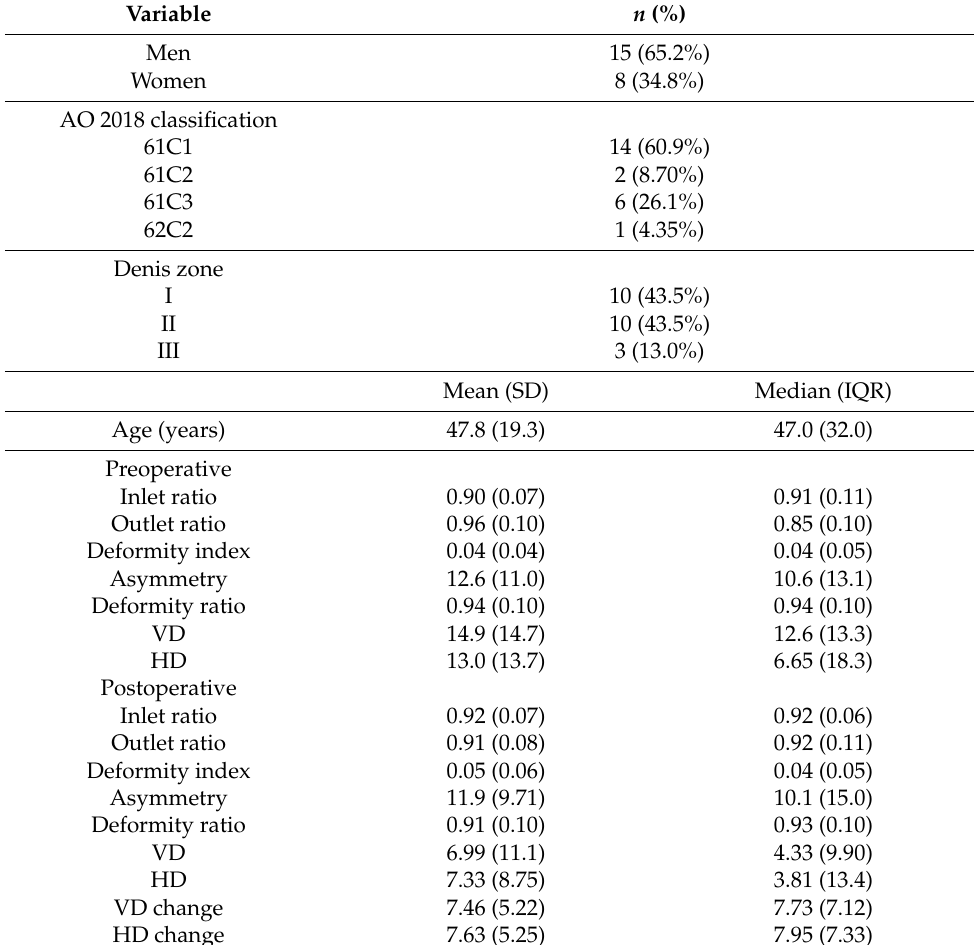
Table 2. Patients’ characteristics ( n =